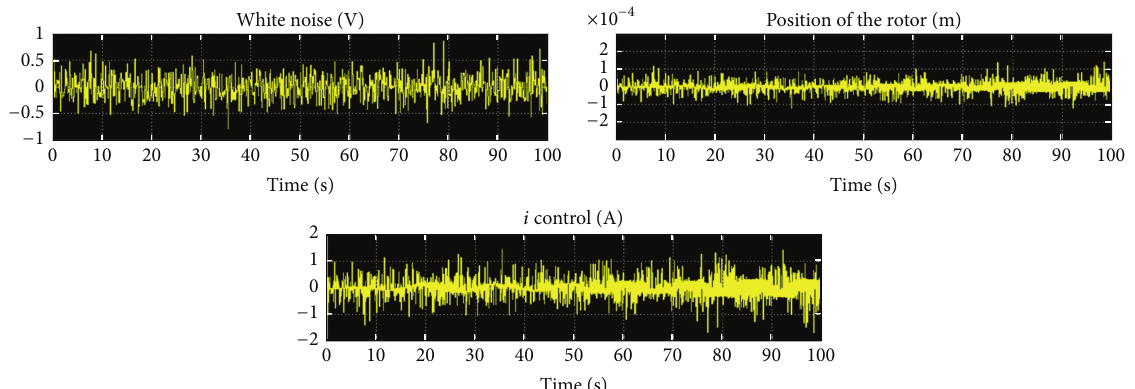
Figure 16: System response with PID controller with proportional gain of 319.0187, integral gain of 1273.2977, and differential gain of 7.2565 and white noise of 0.001 volts.